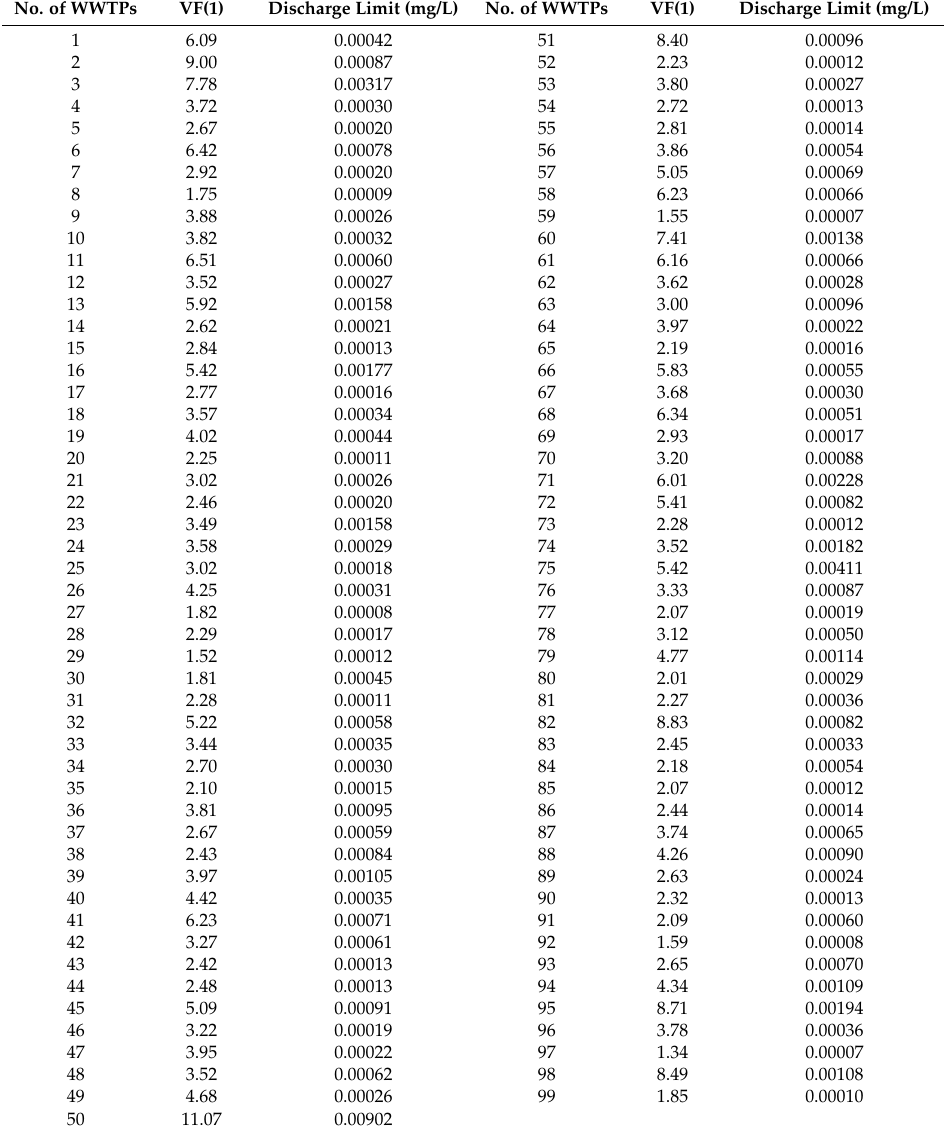
Table 9. VF(1)s and derived discharge limits of Hg for 99